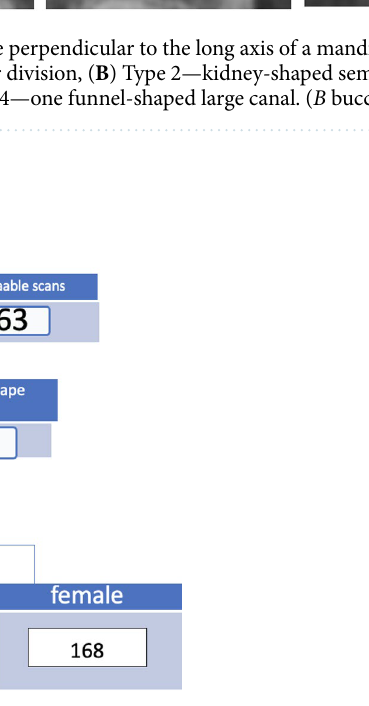
Figure 3. Flow diagram for the eligible